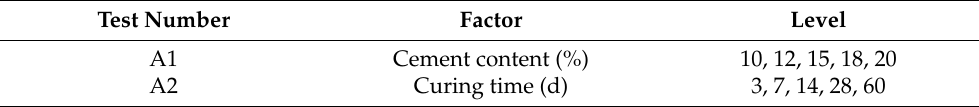
Table 6. Test scheme for compressive strength properties of cement solidified